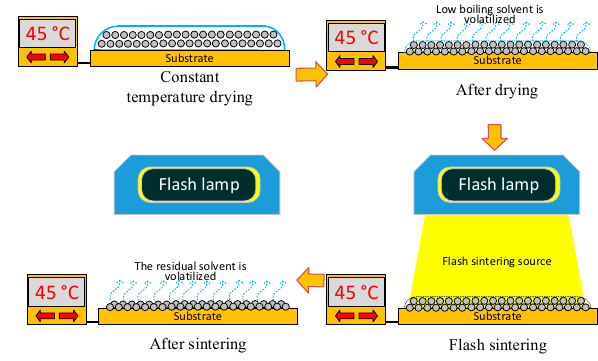
Figure 2. Printing-based sintering system.